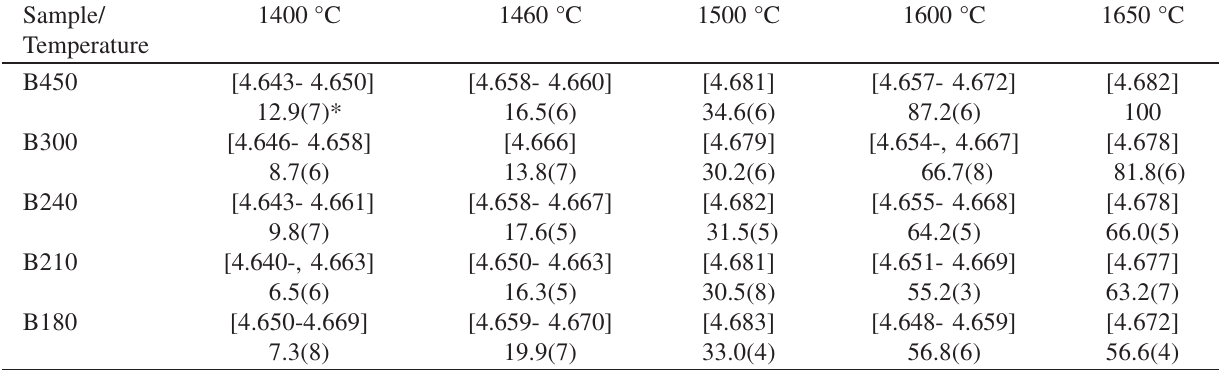
and weight % of Zr(C,O) for ZrO o